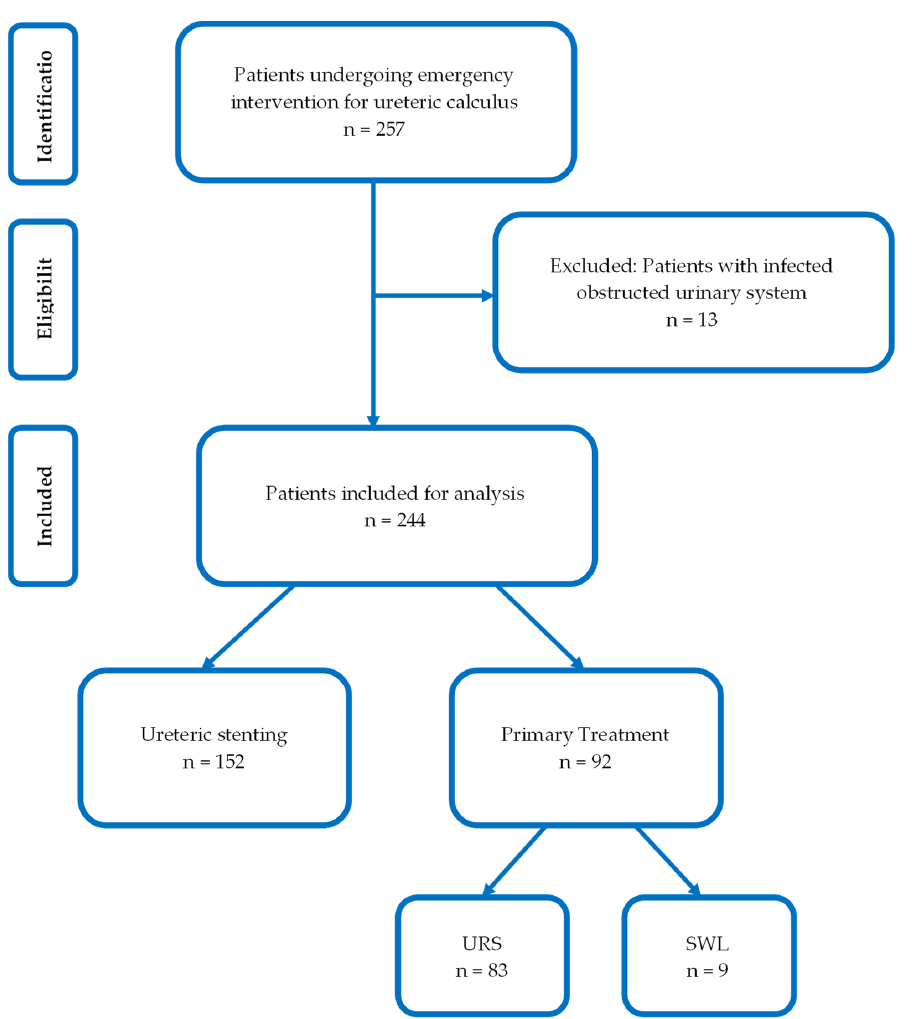
Figure 1. Flowchart demonstrating inclusion and exclusion criteria for the present study.